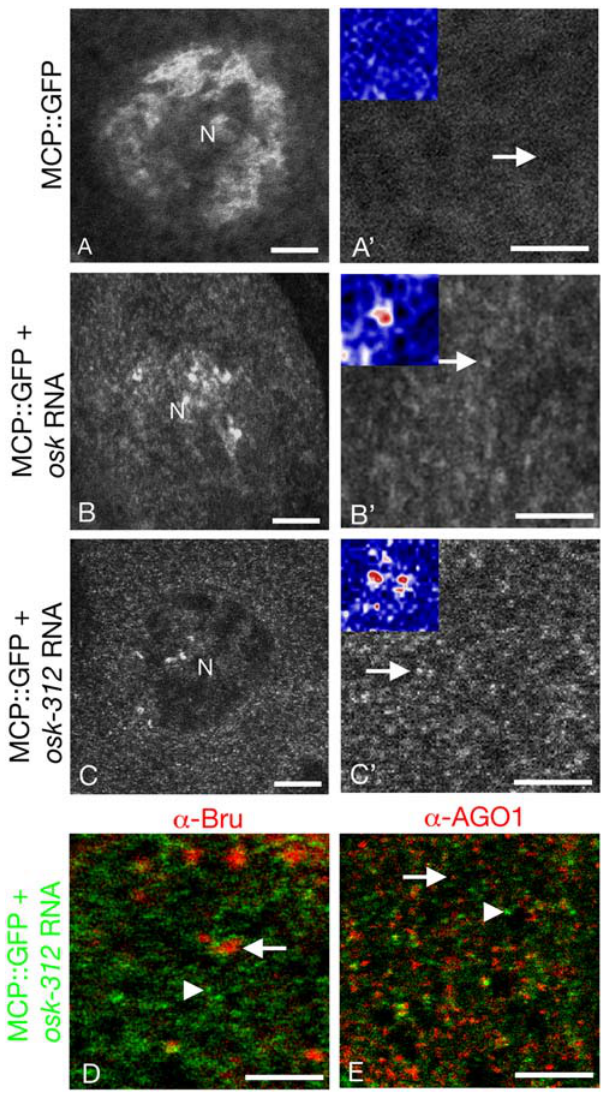
Figure 4. Sites of miRNA action in the ovary. Panels A–C show the distribution of MCP::GFP in nurse cells of live stage 10A egg chambers, with higher magnification images of cytoplasmic regions in A’–C’. Scale bars are 10 m m in A–C and 5 m m in A’–C’. A–C differ with respect to which reporter mRNAs with MS2 binding sites are present: A, no reporter mRNAs; B, reporter mRNAs lacking miR-312 binding sites; and C, reporter mRNAs with miR-312 binding sites. The cytoplasmic MCP::GFP distributions were the same at earlier stages of oogenesis. Note that the size of the particles is similar to those marked with the AGO::GFP fusion proteins in Fig. 3, but the number of particles seen in each field is lower. The insets in A’–C’ are a higher resolution image of the regions in A’–C’ indicated by arrows, with Union Jack LUTs as described in the legend to Fig. 3. MS2::GFP in the presence of the osk reporter mRNAs, with or without miR-312 binding sites, is cosncentrated in puncta (appearing white and red in the insets in B’,C’) that are not observed with MS2::GFP alone (inset in A’). Panels D and E show the distribution of MCP::GFP (green in D and E) tethered to the osk-312 reporter transcripts, and either sponge bodies (revealed by anti-Bru; red in D) or AGO1 puncta (red in E). The sponge bodies and AGO1 puncta (arrows in D and E) do not colocalize with the tethered reporter transcripts (arrowheads in D and E). Scale bars are 5 m m in D and E.